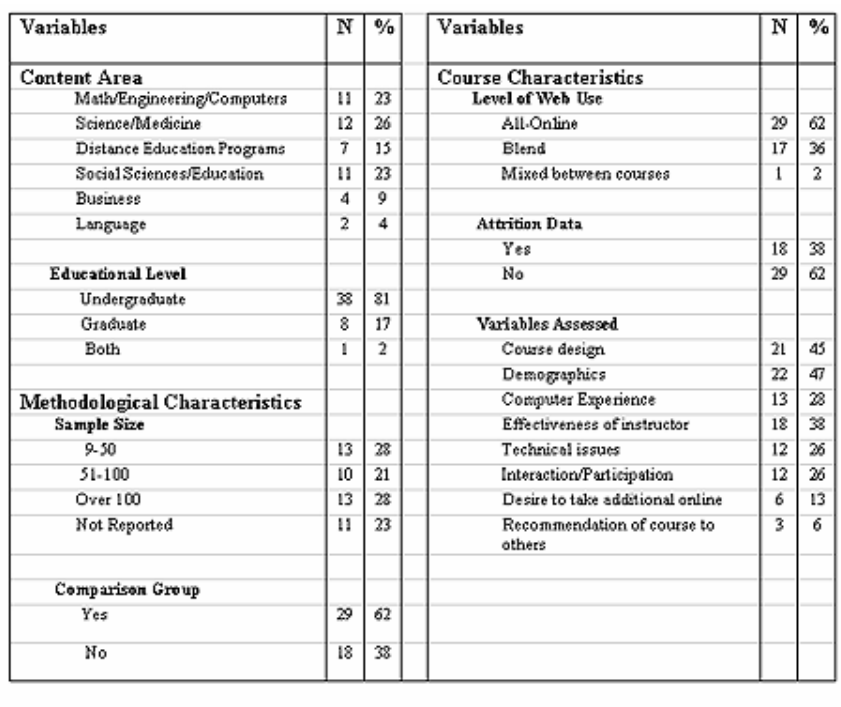
Table 3. Descriptive statistics for studies included in